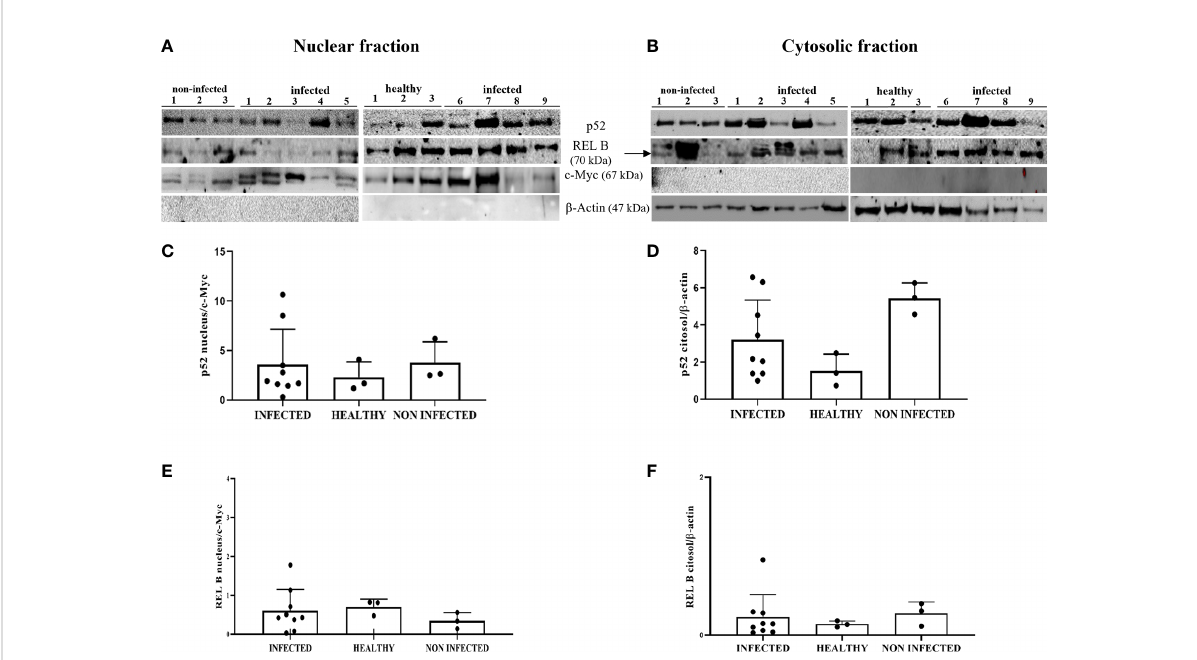
FIGURE 13 (A, B) Nuclear and cytosolic fractions of infected, non-infected, and healthy bladder tissues. The Figure presents western blots of the different fractions of the proteins p52 and RelB. cMyc and b − actin were used to verify the selectivity of the extracts and perform densitometric analysis. (C, D) Densitometric analysis of the nuclear and cytosolic fractions of p52 and (E, F) RelB. No signi fi cant variation is seen in the p52 and RelB protein levels in diseased bladder tissues compared with both non-infected and healthy bladder samples. Plots present values found for each sample performed in